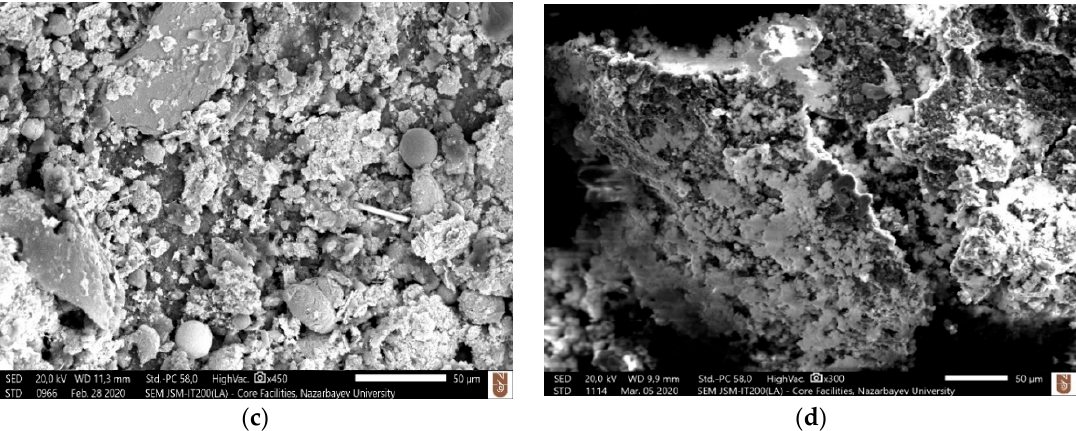
Figure 5. Example of thermal spalling on the machined surface at different experimental conditions, ( a ) Exp 2 (80 V, 1 A, T on = 100 µ s, T off = 250 µ s.), ( b ) Exp 7 (80 V, 1 A, T on = 200 µ s, T off = 200 µ s.), ( c ) Exp 9 (80 V, 1 A, T on = 200 µ s, T off = 300 µ s.), ( d ) Exp 20 (80 V, 3 A, T on = 100 μ s, T off = 250 μ s.).